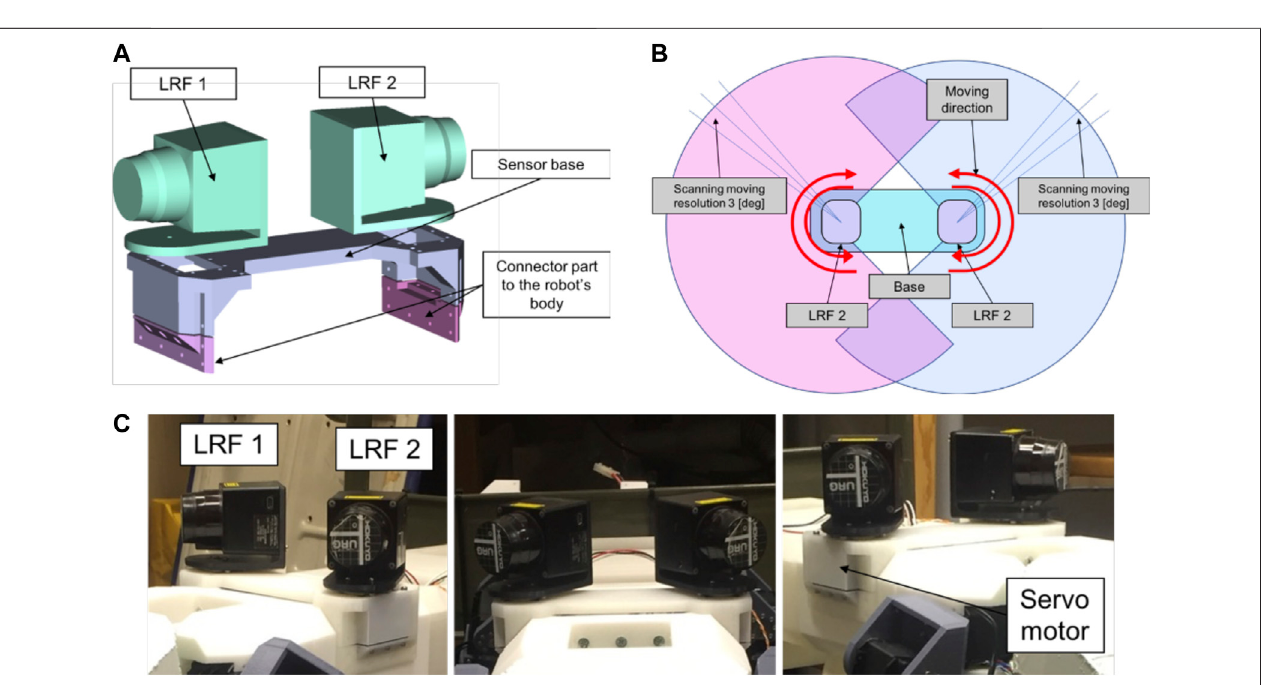
FIGURE 7 | Design of DLRF sensor. (A) CAD design. (B) The structure of the sensor (C) The appearance design of the Dual LRF sensor.